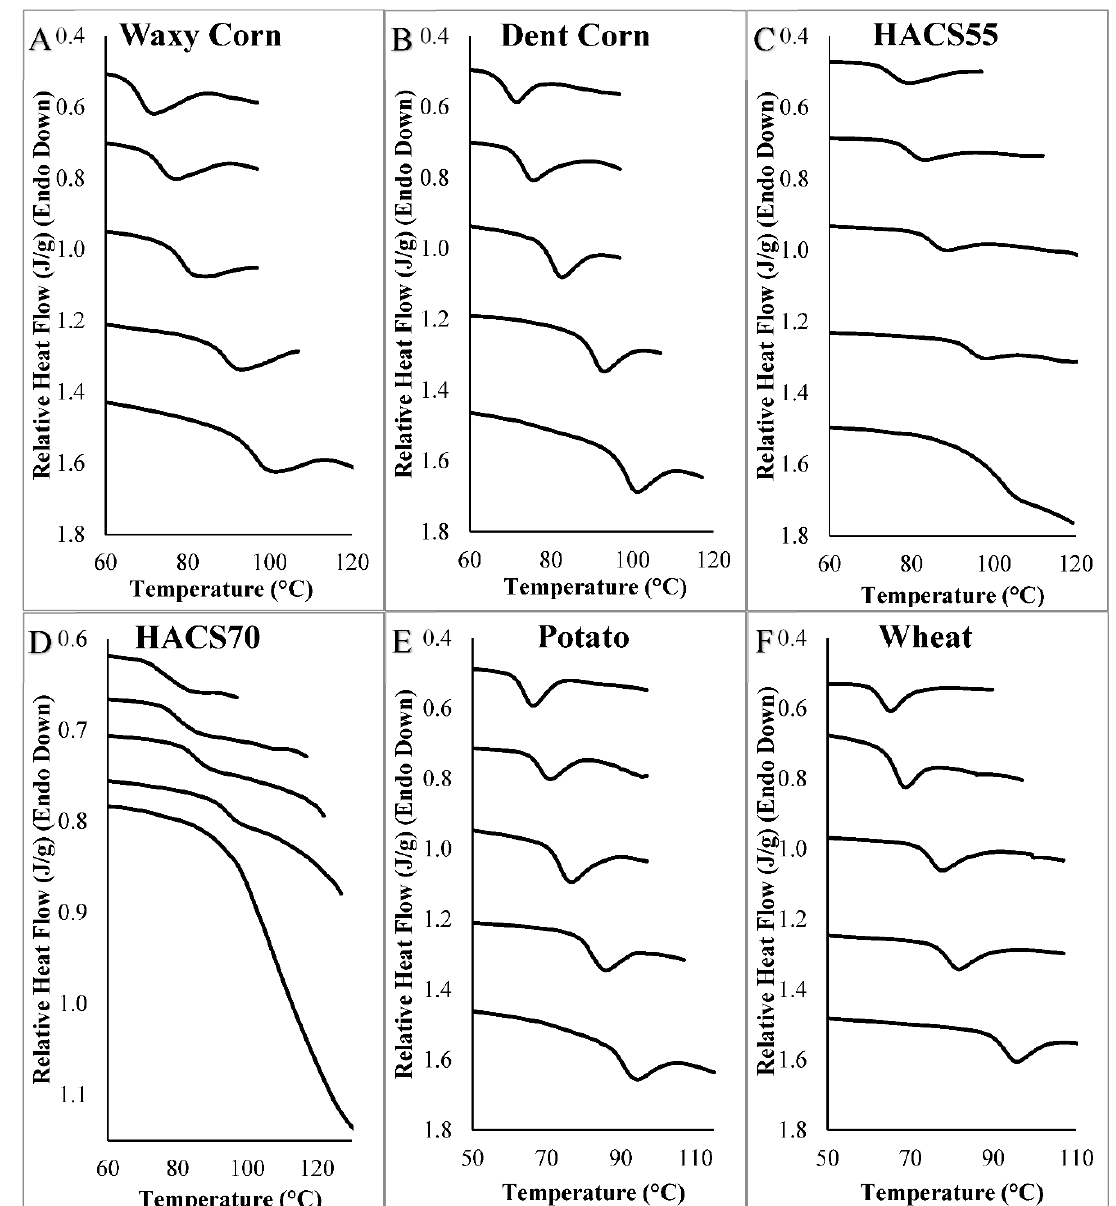
Figure 2. DSC thermograms of 1:2 w/w starch slurries in solutions containing different concentrations of sucrose: ( A ) waxy corn, ( B ) dent corn, ( C ) HACS55, ( D ) HACS70, ( E ) potato, and ( F ) wheat starch. Thermograms are shown from top to bottom from: control, 0.5 M sucrose, 1.0 M sucrose, 1.5 M sucrose, and 2.0 M sucrose.